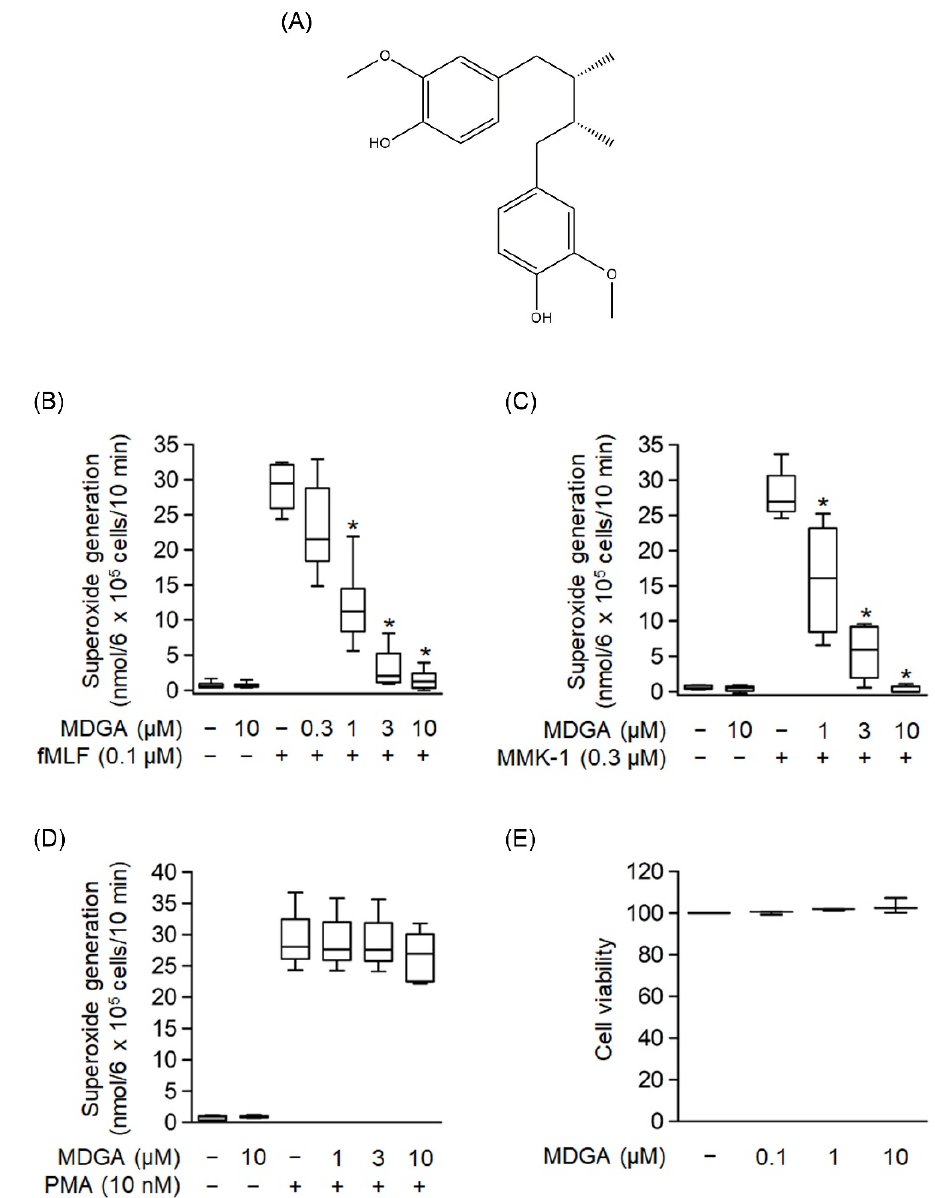
Figure 1. Effects of meso -dihydroguaiaretic acid (MDGA) on superoxide anion generation in human neutrophils. ( A ) Chemical structure of MDGA. ( B – D ) Superoxide anion generation was monitored using ferricytochrome c reduction. Visualization was carried out using a spectrophotometer at 550 nm after human neutrophils were incubated with dimethyl sulfoxide (DMSO, 0.1%, as control) or MDGA (0.3–10 μ M) for 5 min, and thereafter stimulated by ( B ) N -formyl-Met-Leu-Phe (fMLF, 0.1 μ M) + cytochalasin B (CB, 1 μ g/mL) for 10 min, ( C ) Leu-Glu-Ser-Ile-Phe-Arg-Ser-Leu-Leu-Phe-Arg-Val-Met (MMK-1, 0.3 μ M) + CB (1 μ g/mL) for 10 min, or ( D ) phorbol 12-myristate 13-acetate (PMA, 10 nM) for 15 min, ( n = 5 or 6). ( E ) Human neutrophils were incubated with DMSO (0.1%, as control) or MDGA (0.1, 1, and 10 μ M) for 15 min. MDGA had no cytotoxicity in human neutrophils as revealed by LDH assay, ( n = 3). The values are shown as the mean ± S.E.M. * p < 0.05 vs. stimulated control.